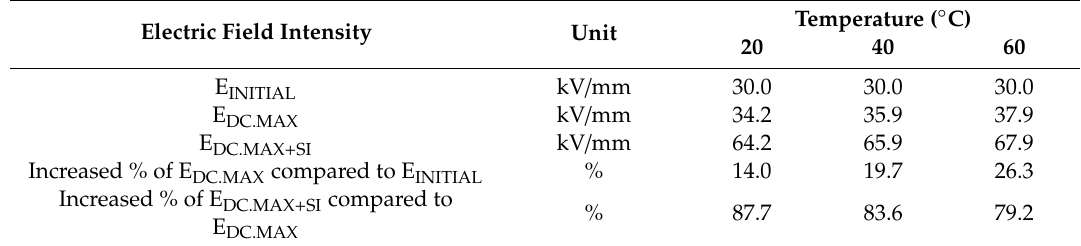
Table 3. Summary of maximum electric field intensity according to simulation condition. Electric Field